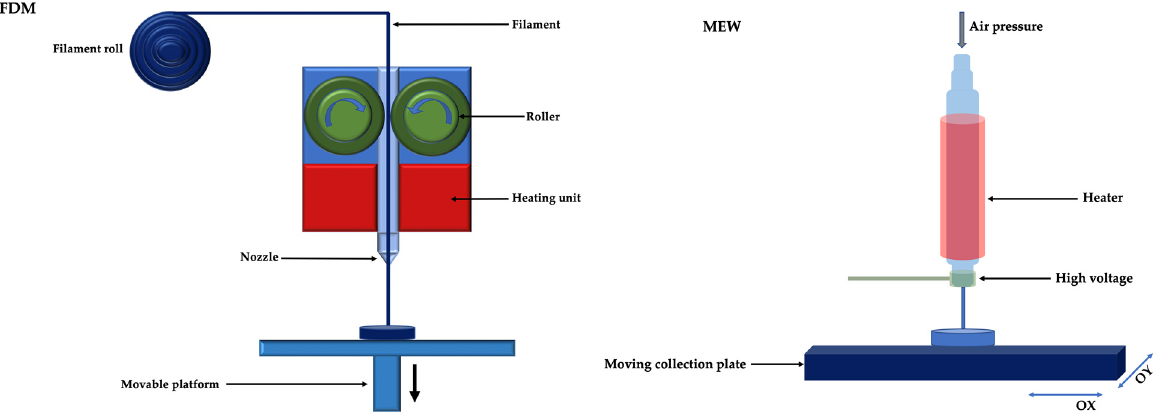
Figure 7. Thermal extrusion 3D printing: fused deposition modelling ( right ) and melt electrowrit- ting ( left ).